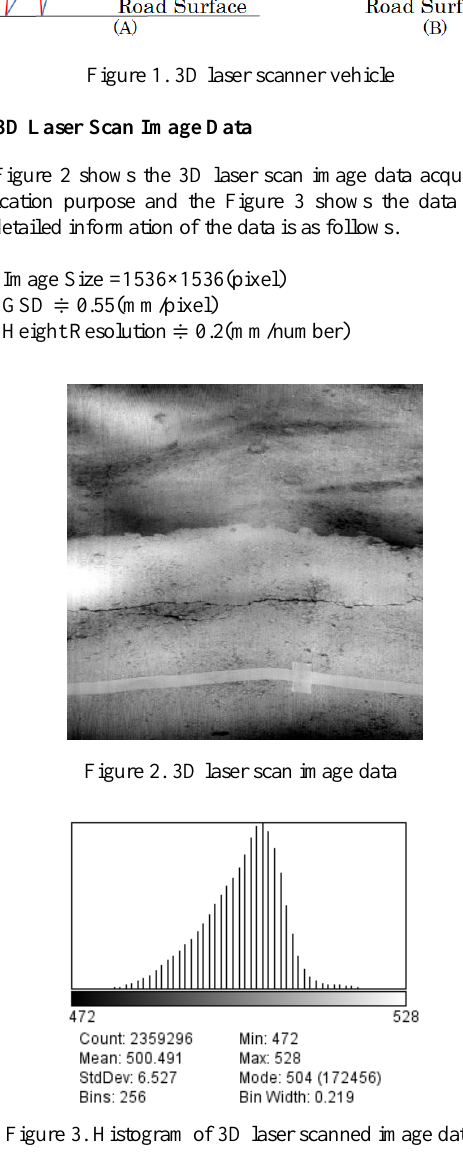
Figure 4. Profile of paved road surface